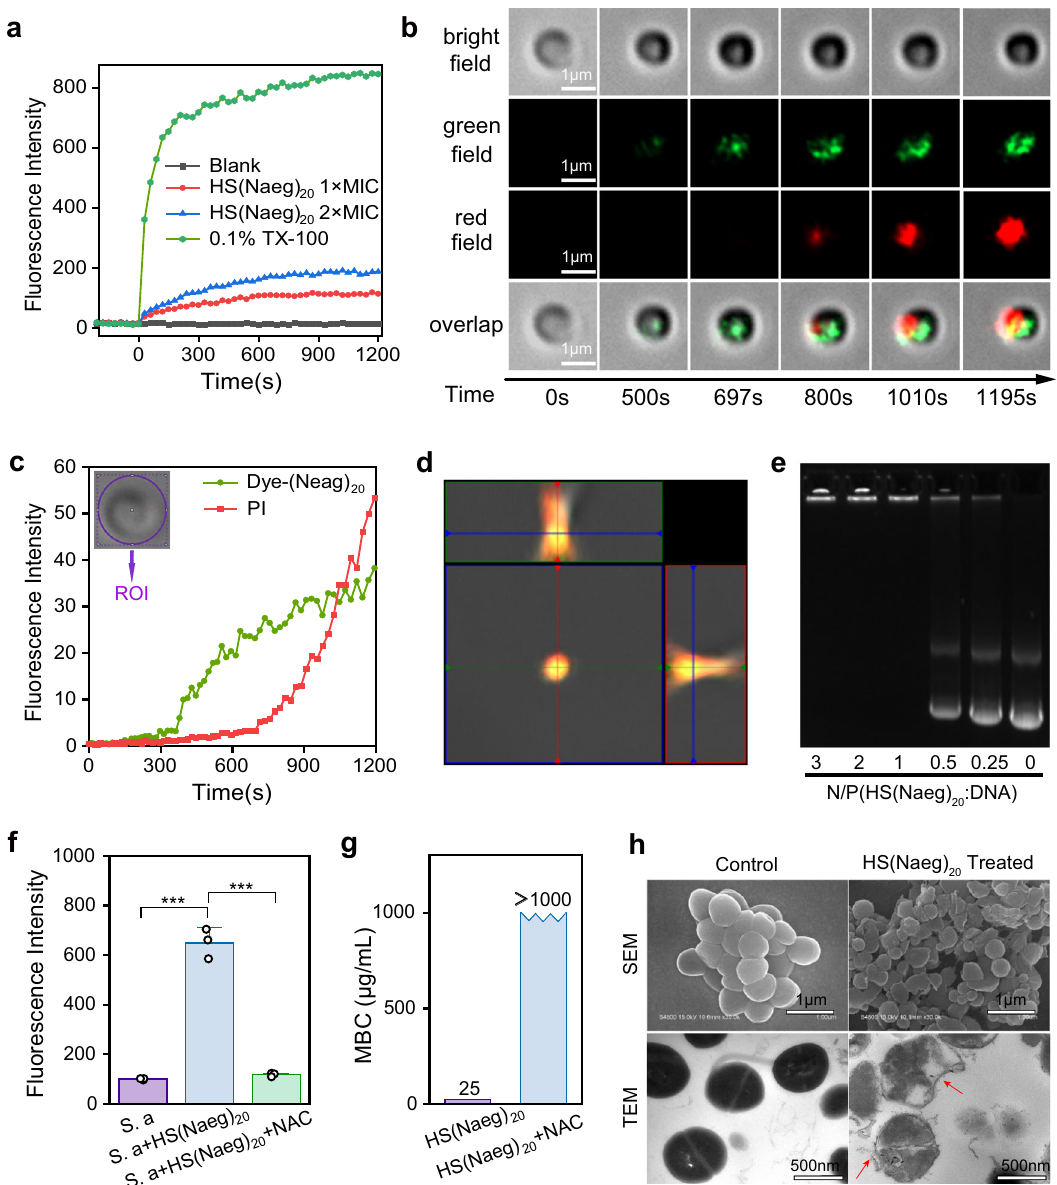
Fig. 3 Antibacterial mechanism study of poly-Naeg. a Cytoplasmic membrane depolarization by HS(Naeg) 20 at 1×MIC and 2×MIC concentrations. b Time-laps confocal fl uorescence imaging on the interaction between S. aureus and dye – (Naeg) 20 at a concentration of 1×MBC, in the presence of PI. c Fluorescence intensity versus time in green and red channels in ROI. d Ortho view of Z-stack images in ( b ). e The electrophoretic mobility shift assay of plasmid DNA and the mixture of plasmid DNA-complexes at different ratios of N:P (HS(Naeg) 20 :DNA). f Fluorescence intensity produced by S. aureus treated with PBS buffer, HS(Naeg) 20 (1 × MBC) and the combination of HS(Naeg) 20 (1 × MBC) and NAC (10 mM), in the presence of 2 ’ ,7 ’ - dichloro fl uorescin diacetate ( n = 3 per group). Data are presented as mean ± SD. *** P < 0.001 (Student ’ s t test). g The MBC of HS(Naeg) 20 against S. aureus in the presence or absence of NAC (10 mM). h SEM and TEM characterization respectively on S. aureus cells with and without HS(Naeg) 20 treatment at a concentration of 1 ×